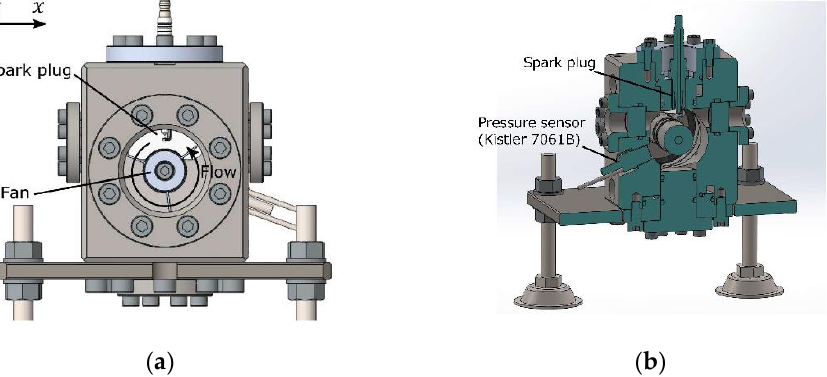
Figure 1. Constant volume combustion chamber. ( a ) Front view; ( b ) Cross-sectional view.